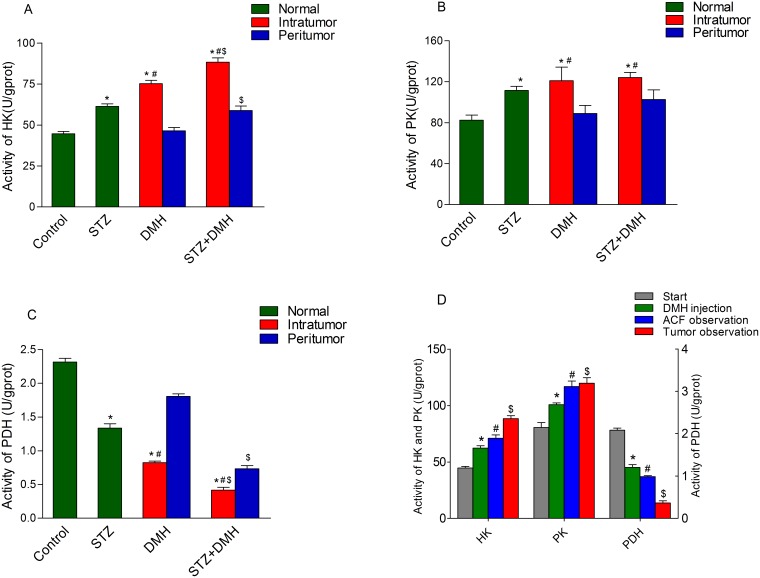
Bar charts demonstrating the enzyme activities in colon tissues.No tumor formation was detected in the Control group and STZ group, so dissect the samples at random. Samples were collected from the intratumoral and the peritumoral regions respectively in the DMH group and STZ+DMH group. The activities of hexokinase (HK), pyruvate kinase (PK) and pyruvate dehydrogenase (PDH) in colonic tissues were measured. Values are expressed as mean ± S.E.M. and analyzed using unpaired student’s T test at P<0.05. Fig. 6A: Analysis of HK. *P<0.05 vs. Control group. #P<0.05 vs. Peritumor respectively. $P<0.05 vs. DMH group respectively; Fig. 6B: Analysis of PK. *P<0.05 vs. Control group. #P<0.05 vs. Peritumor respectively; Fig. 6C: Analysis of PDH. *P<0.05 vs. Control group. #P<0.05 vs. Peritumor respectively. $P<0.05 vs. DMH group respectively. Fig. 6D: Analysis of HK, PK and PDH activities at different time course in the STZ+DMH group. *P<0.05 vs. Start point respectively. #P<0.05 vs. STZ injection respectively.